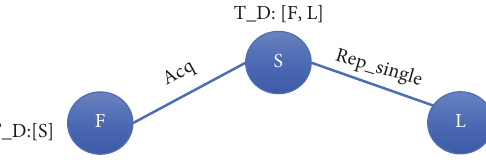
Figure 9: One-step resource sharing in normal conditions.